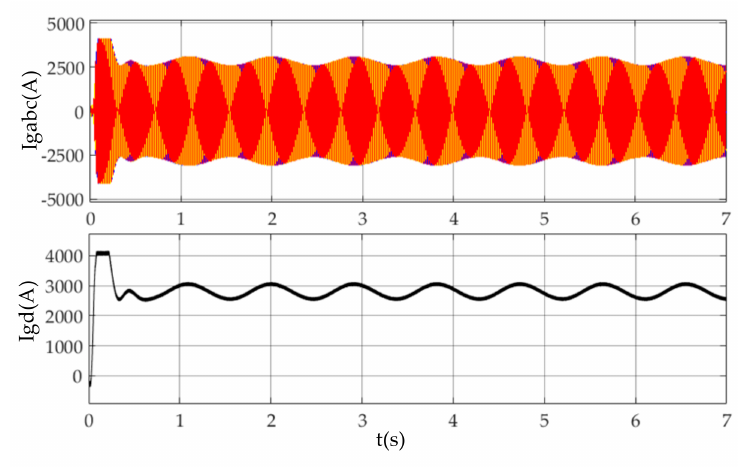
Figure 10. The waveform of grid line current.